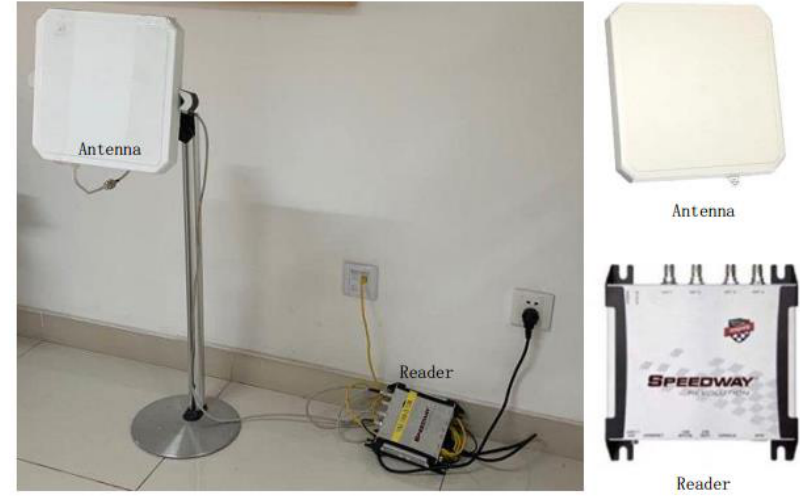
Figure 5. System Figure 5. System deployment. Figure 5. System deployment.